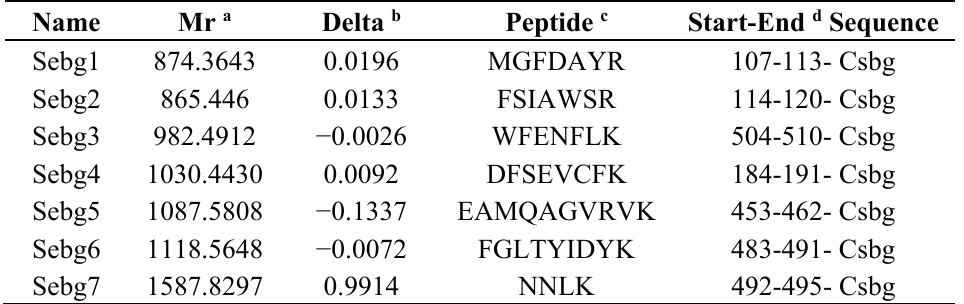
a Relative mass calculated. b Difference between experimental and calculated relative masses. c Peptide